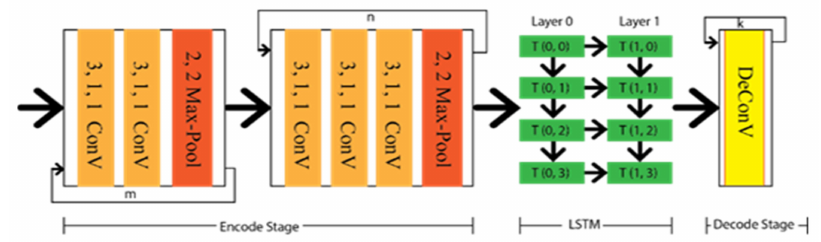
Figure 9. Schematic diagram of CNN-LSTM.